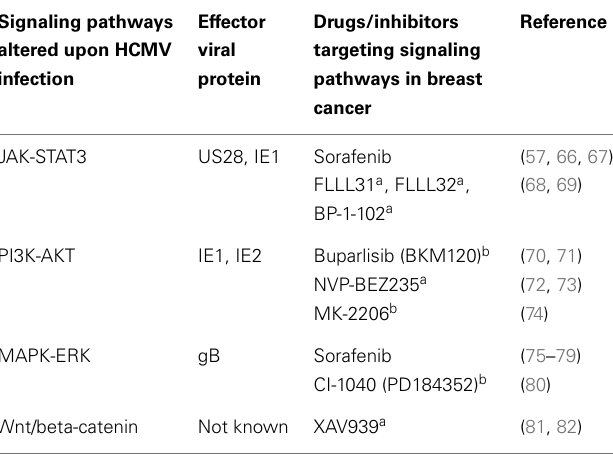
Table 3 | Major signaling pathways targeted by HCMV and activated in breast cancer